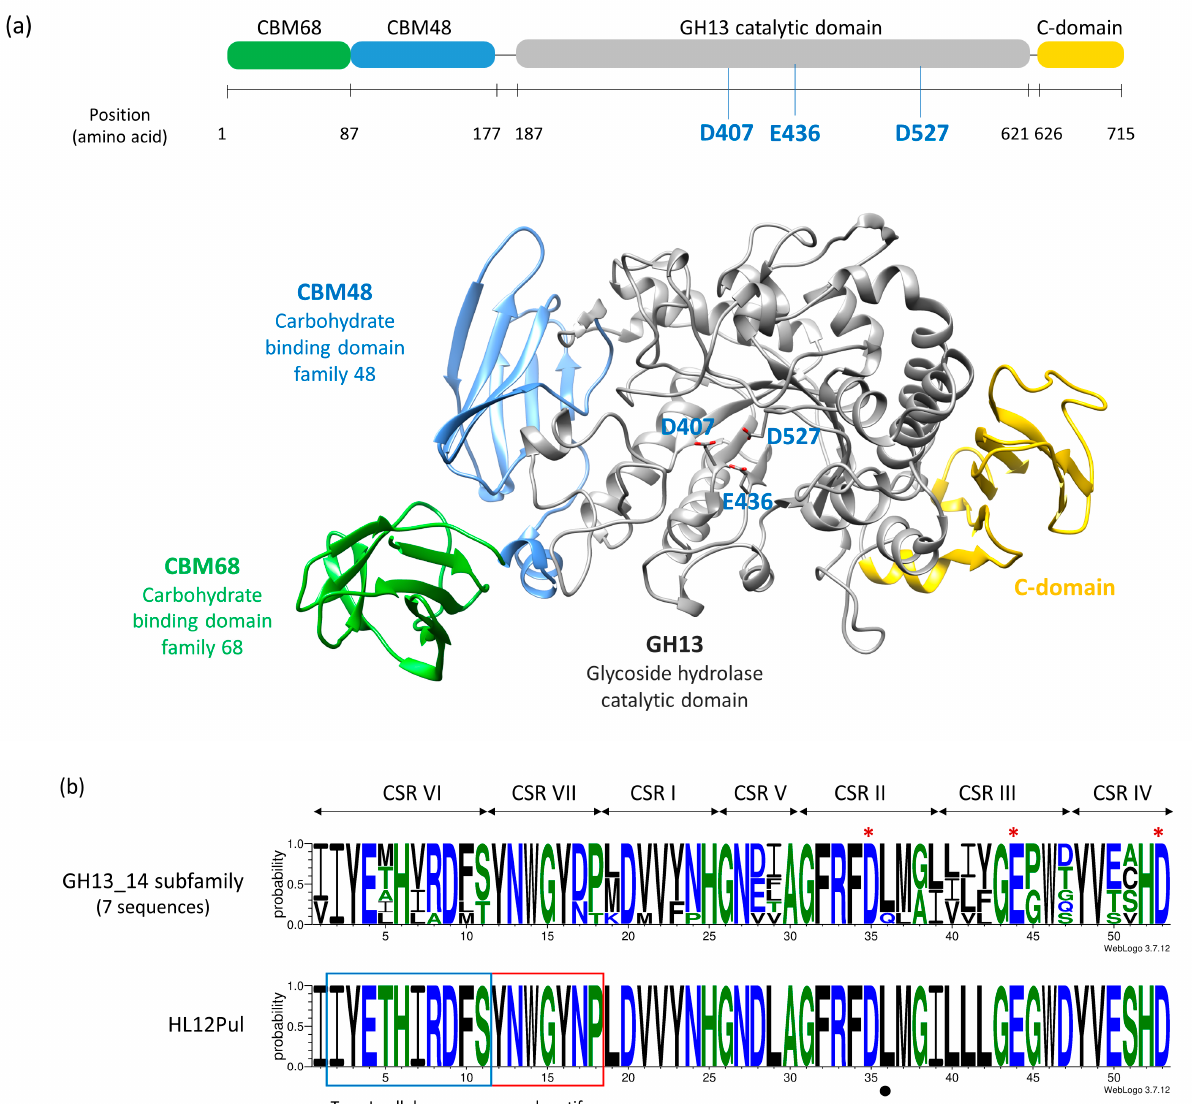
Figure 2. Schematic representation of domain organization in HL12Pul and the overall predicted three-dimensional structure of HL12Pul from P. koreensis HL12. ( a ) The structure was predicted based on type I pullulanase from Anoxybacillus sp. LM18-11 (PDB: 3wdh) using the SWISS-MODEL. The proposed catalytic residues were presented in the model (D407/E436/D527). ( b ) Sequence logos of eight conserved sequence regions (CSRs) found in HL12Pul and biochemically characterized pullulanase type I belonging to the GH13_14 subfamily. Seven type I pullulanases in sequence alignment are from Anaerobranca gottschalkii (AAS47565), Bacillus acidopullulyticus (CAC60156), Bacillus subtilis strain 168 (AAC00283), Exiguobacterium sp. SH3 (AJG04842), Fervidobacterium pennavorans Ven5 (AAD30387), Paenibacillus polymyxa Nws-pp2 (AIE88189), and Anoxybacillus sp. LM18-11 (3wdh). The proposed catalytic residues (D407/E436/D527) are indicated by red asterisks. The IYETHIRDFS and YNWGYNP conserved motifs of type I pullulanase are highlighted in the blue and red box, respectively. The unique residue important for α -1,6 glycosidic linkage hydrolyzing activity is indicated by the black